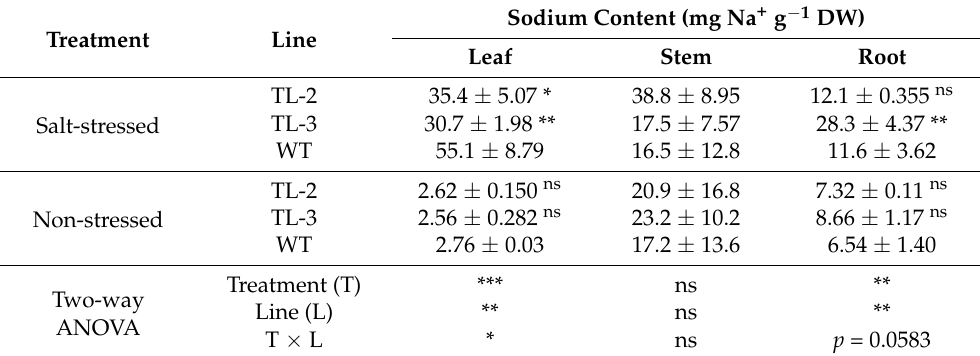
Table 4. Sodium content of transgenic faba bean lines TL-2, TL-3, and wild-type (WT) after 29 days of salt stress followed by a 14-day recovery period. Values are means ± SE. Asterisks indicate significant differences within treatment by Dunnett’s test using WT as control upon significant interaction indicated by two-way ANOVA. *** p < 0.001, ** p < 0.01, * p < 0.05, ns insignificance with p > 0.05.